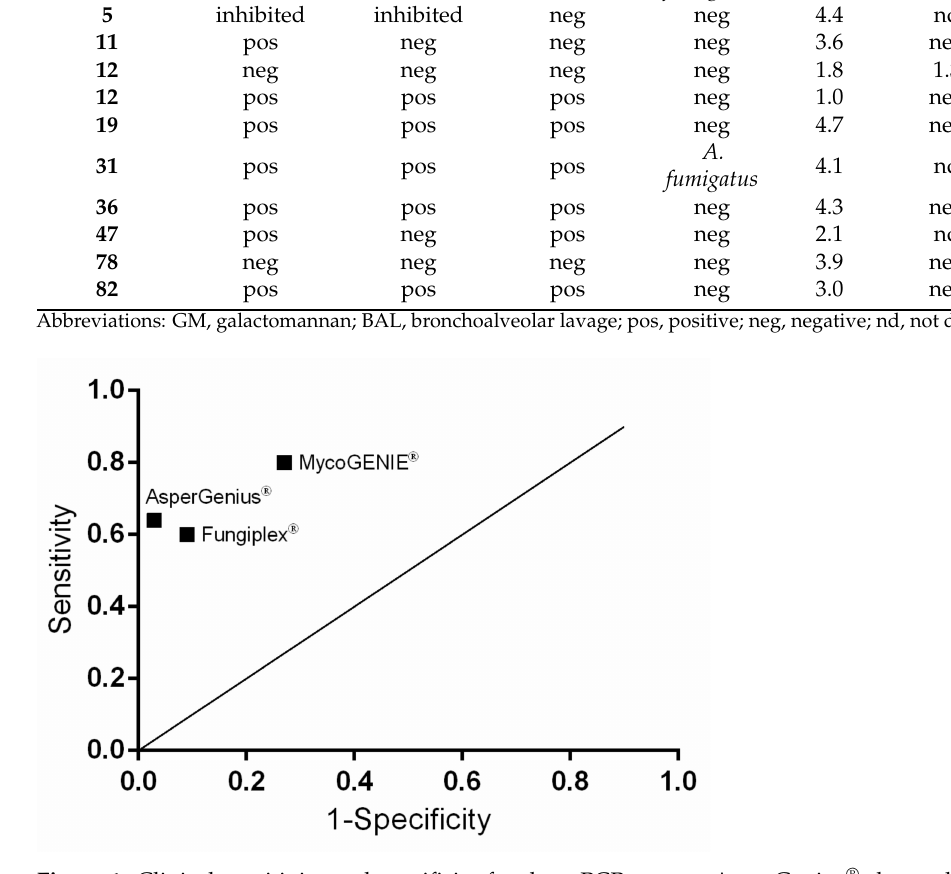
Figure 1. Clinical sensitivity and specificity for three PCR assays. AsperGenius ® shows the best connection between sensitivity and specificity, while MycoGENIE ® shows a high sensitivity but low specificity. Diagonal line represents random results. Table 3. Positive PCR assays categorised as probable, possible and not categorisable IPA